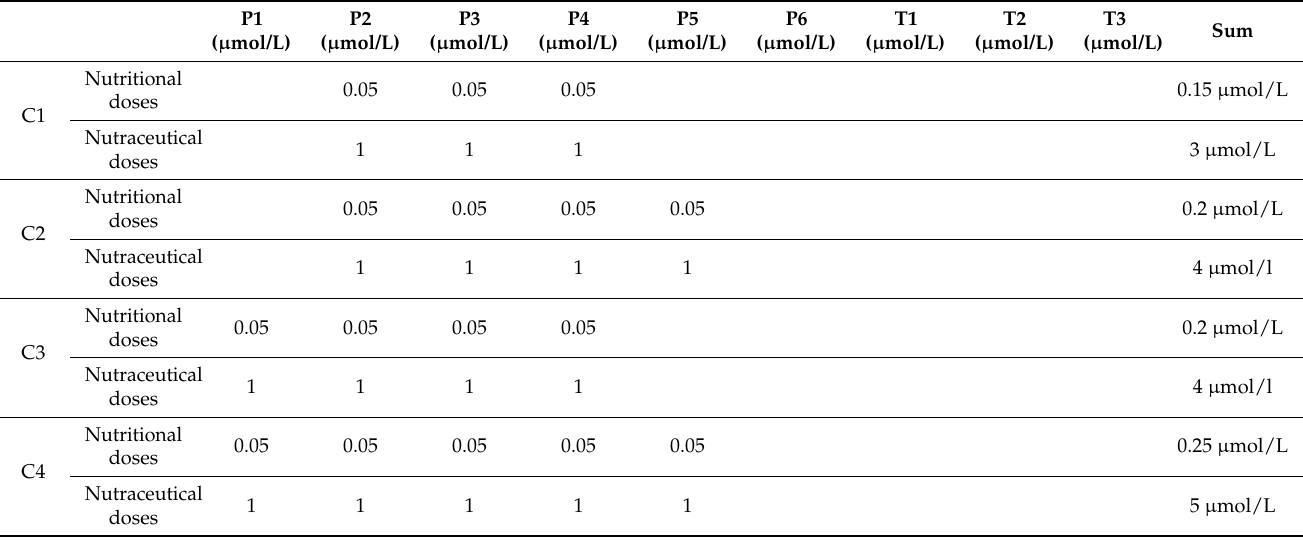
Table 2. Extract combination strategy 1